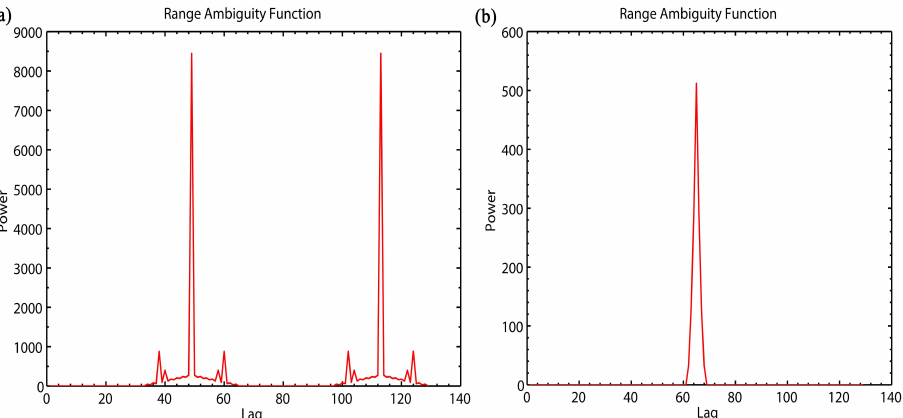
Figure 7. ( a ) Range ambiguity function of 4-bit strong alternating code modulated by 16-bit comple- mentary code and ( b ) Range ambiguity function of 16-bit strong alternating code.